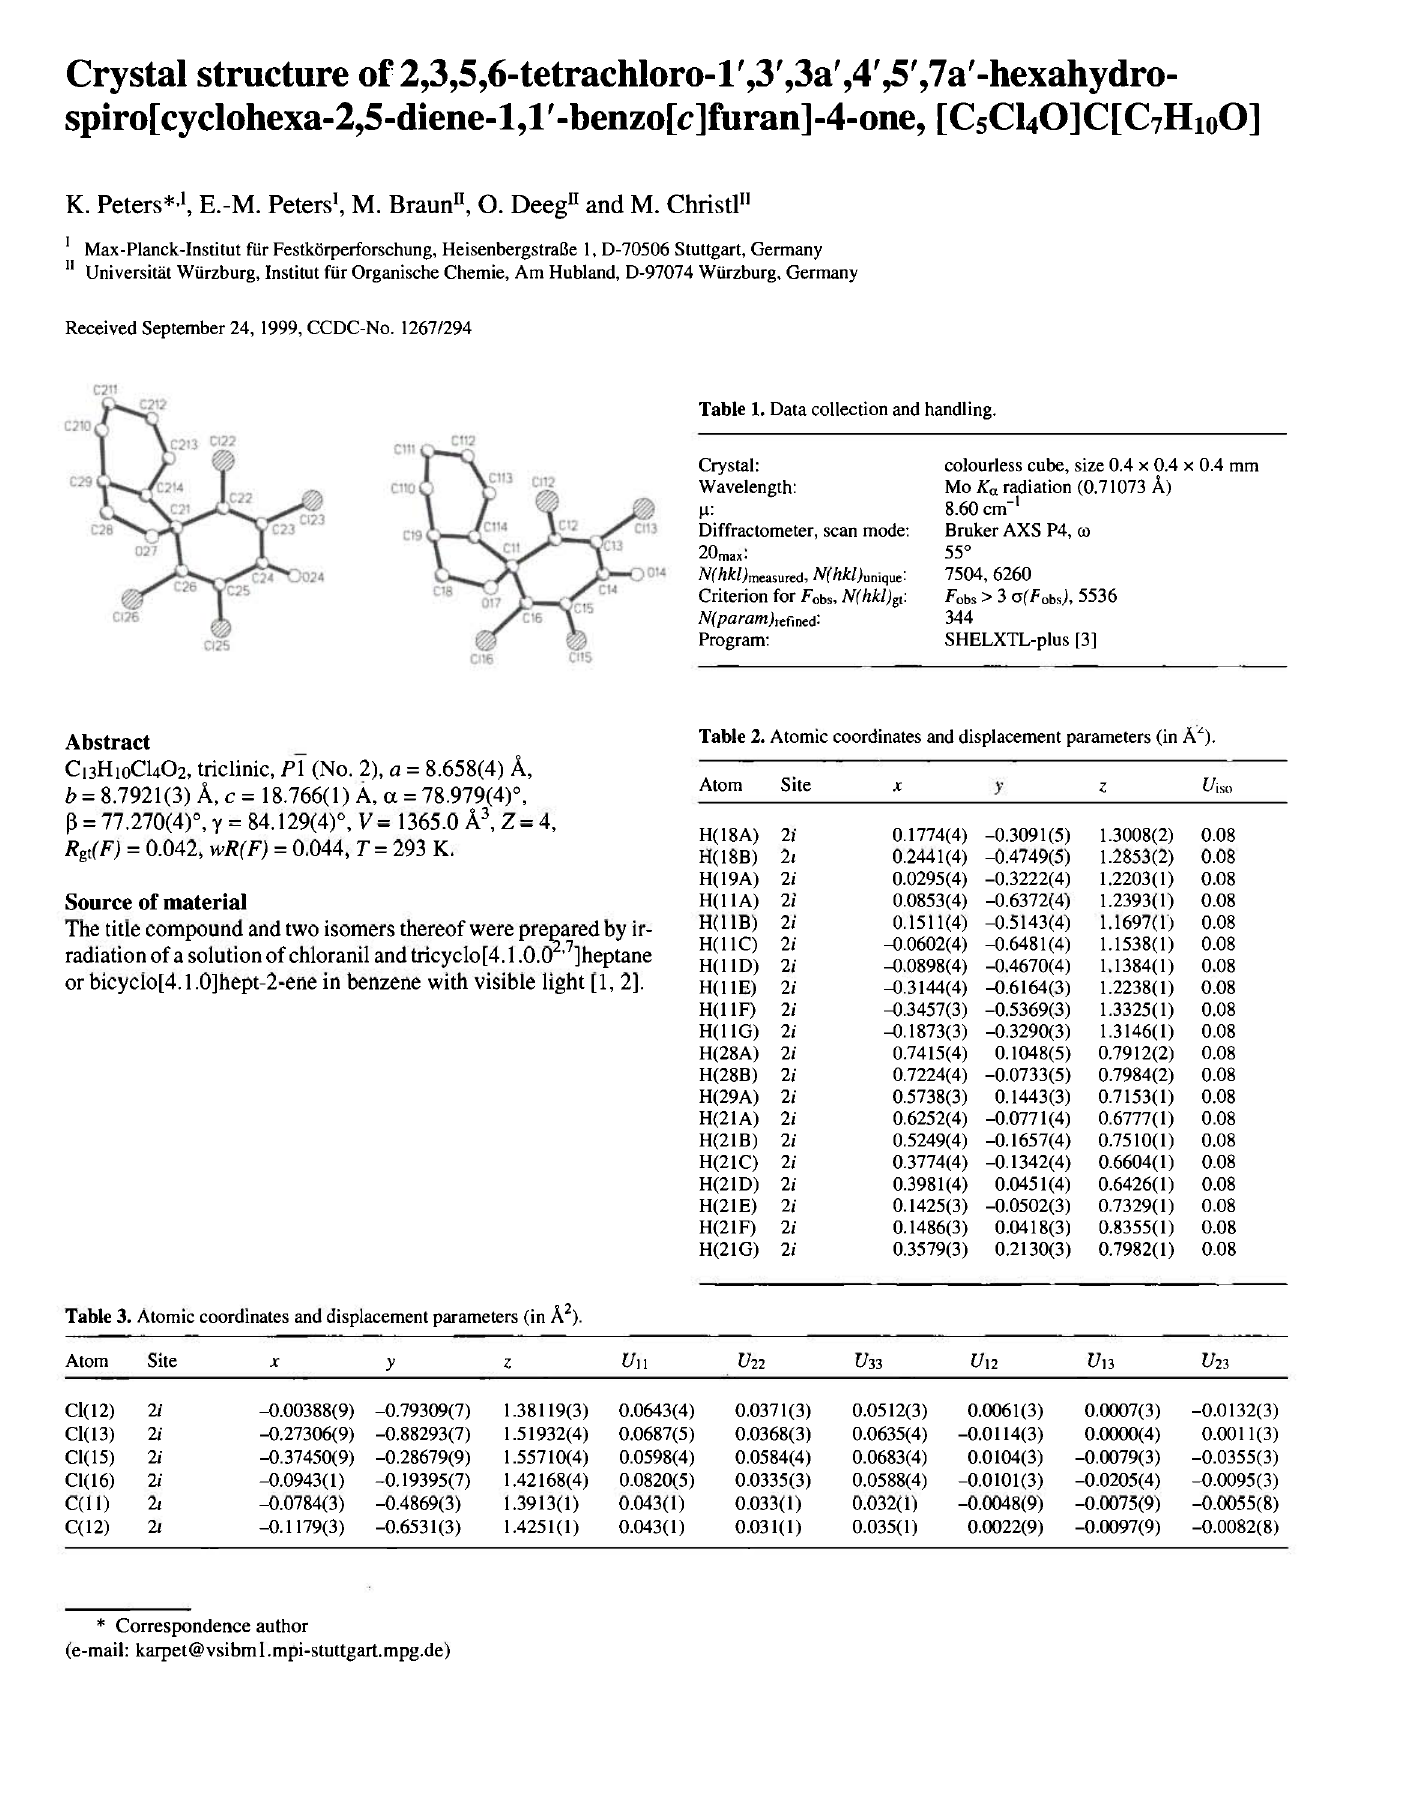
Table 3. Atomic coordinates and displacement parameters (in Ä 2